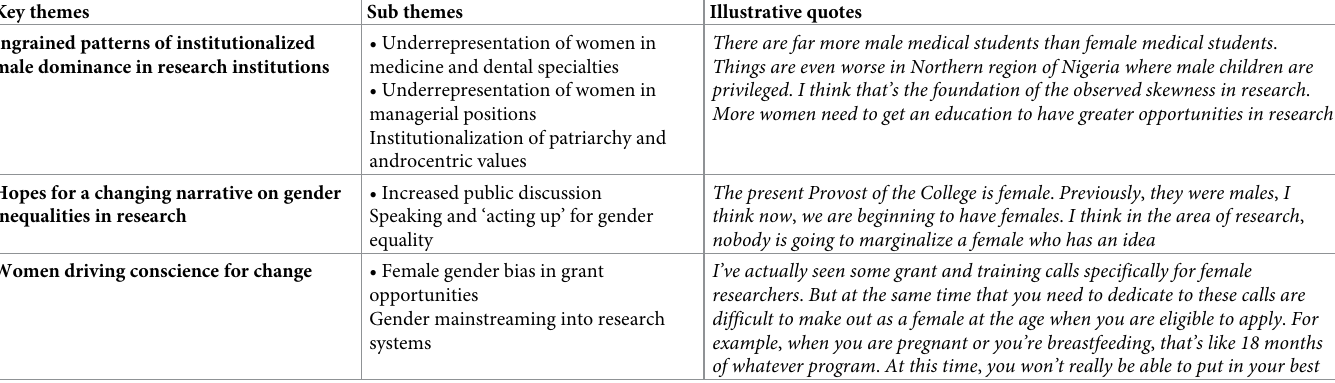
Table 3. Emergent themes, subthemes, and illustrative